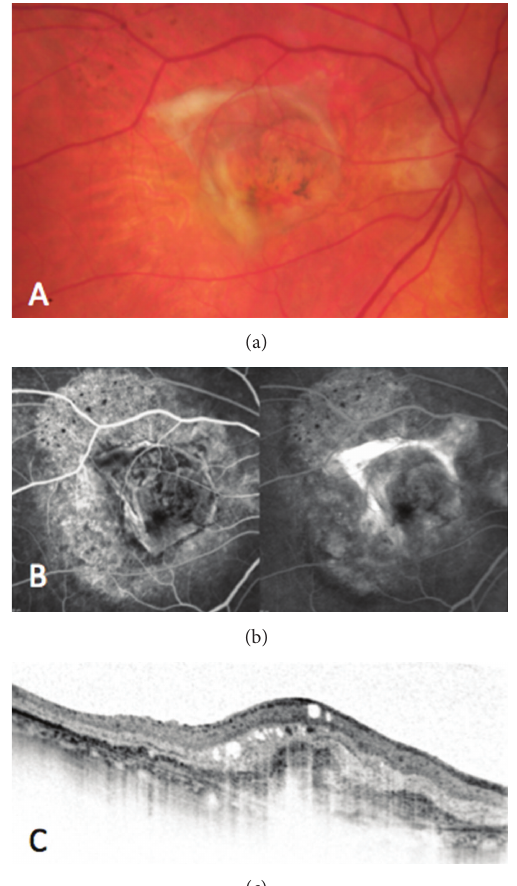
Figure 2: Discrepancy between imaging modalities regarding iden- tification of signs considered to indicate CNV activity: color fundus photography (a) demonstrates fibrosis and RPE changes, fluorescein angiography (b) demonstrates staining of CNV, and SDOCT (c) shows intraretinal cystoid